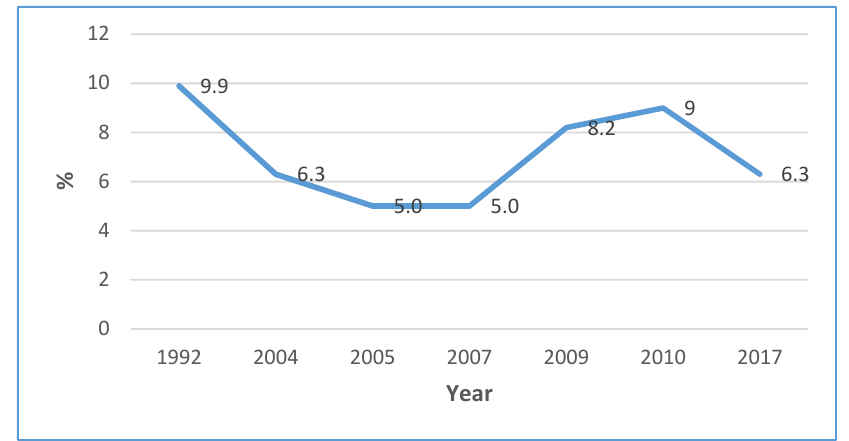
Figure 1. Agricultural sector contribution to Gross Domestic Product (GDP). Source: [39].